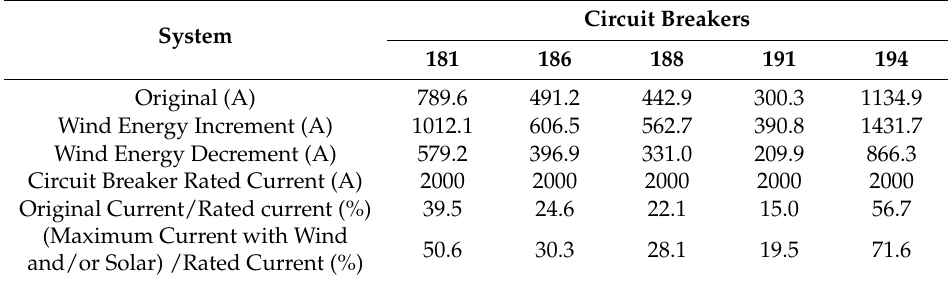
Table 2. Maximum Currents (A) Through Circuit Breakers of João Câmara II 138 kV Substation.